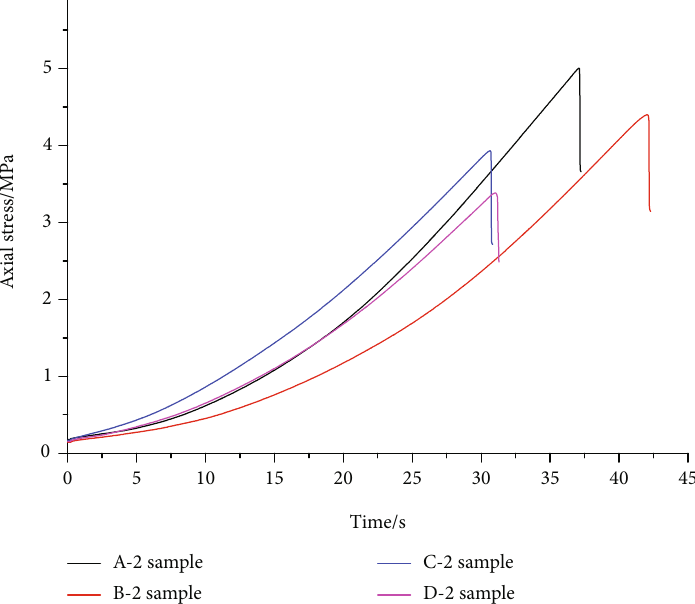
Figure 5: Typical stress-time curves of sandstone samples.